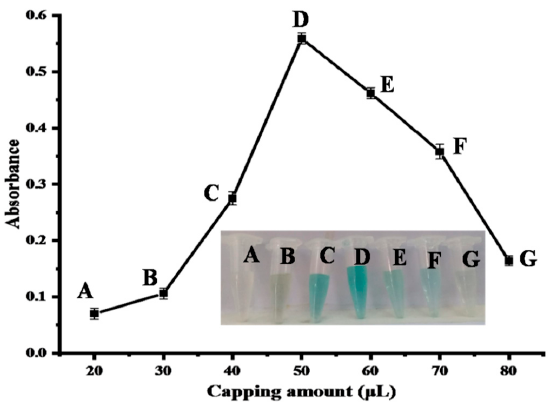
Figure 7. Optimization of the amount of capped Co/CeO 2 /C nanocomposites in (20–80 µL). At 50 µL of Co/CeO 2 /C/IL, TMB = (180 µL of 10 mM), PBS = 500 µL of pH 7.0, and H 2 O 2 = 85 µL of 6 mM the best response was observed. The absorbance was measured in the range of 200–800 nm.